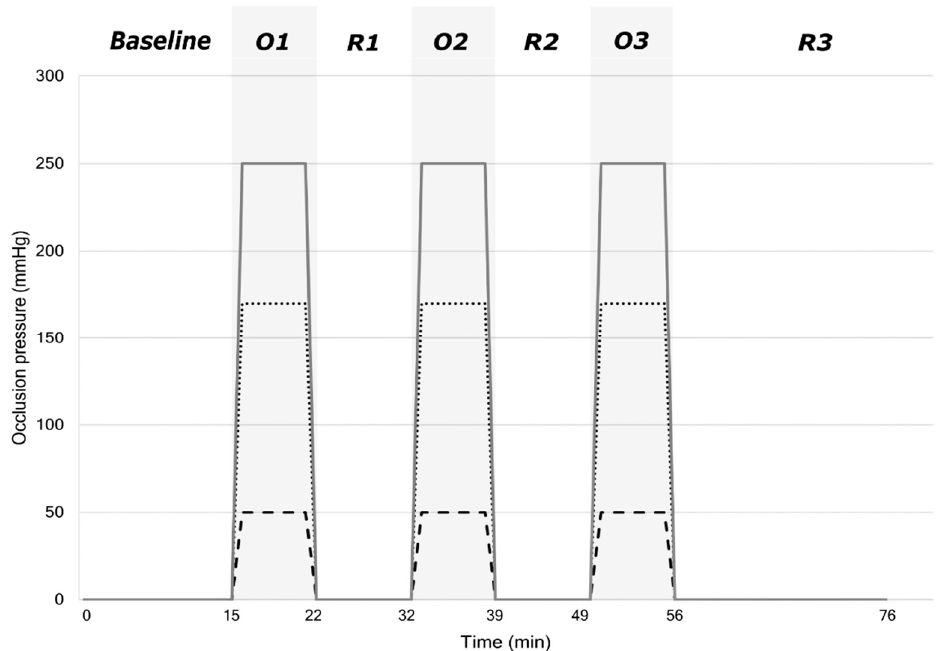
Figure 1. Participants were lying on a medical couch for the duration of the session in the dark and asked to avoid any movement which could disturb the signal. After a 15 min baseline period, the cuff placed on the left arm was inflated to induce three occlusion phases (O1, O2, O3) each of seven minutes. Each occlusion phase was followed by a reperfusion period (R1 = 10 min, R2 = 10 min, R3 = 20 min).